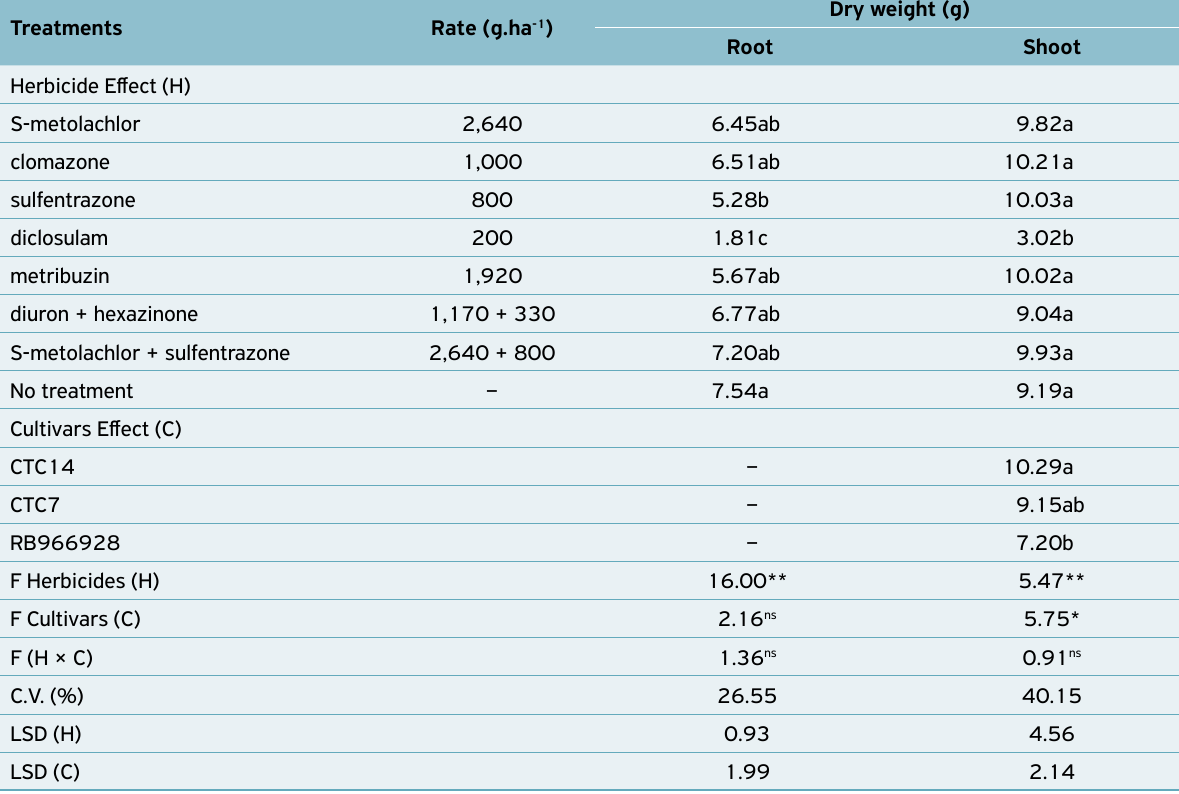
Table 6. Mean values of the dry weight shoot and dry weight root on the 63 rd DAA in pre-planting of different herbicides in three sugar cane cultivars. Pradópolis, state of São Paulo, Brazil, 2013.